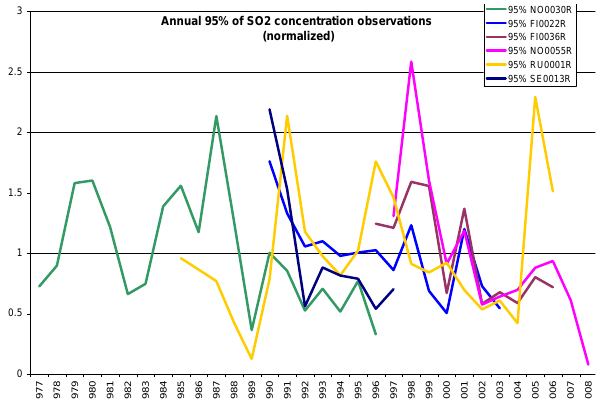
Fig. 3. Time series of the 95th percentile of the measurements of Figure 3. Time series of the 95th percentile of the measurements of SO2 concentration in air SO 2 concentration in air by the stations near Nikel, normalised to by the stations near Nikel, normalised to unit average. unit Note: Station Code